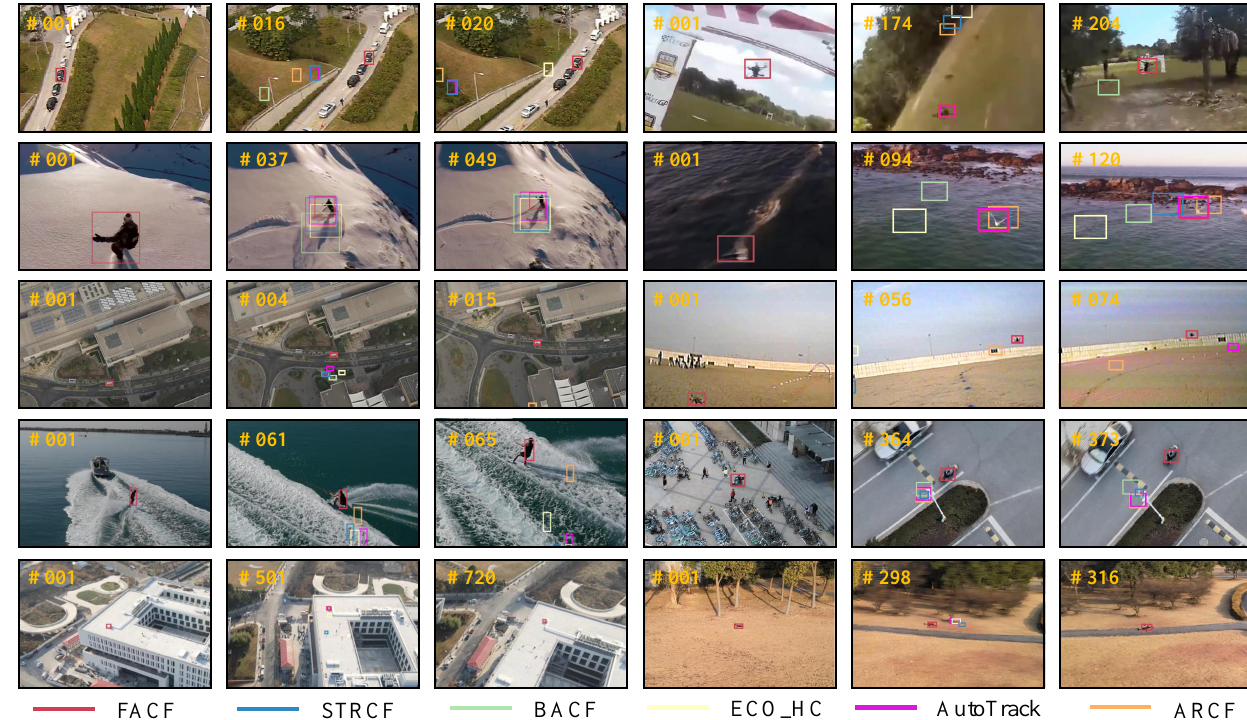
Figure 7. Visualization of the tracking results between the proposed tracker and 5 other state-of-the-art trackers on 10 challenging sequences. From left to right and from top to bottom are Car2, ChasingDrones, Gull1, and Snowboard- ing from DTB70 [25]; car13, uav3, and wakeboard from UAV123_10fps [26]; and courier1, electric box,and uav1 from UAVTrack112